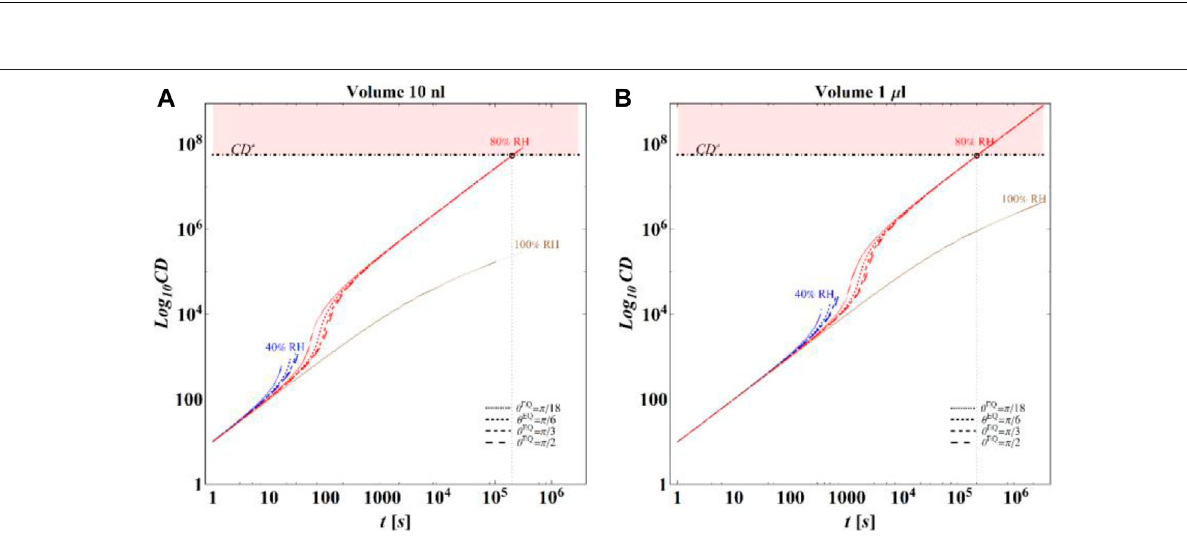
FIGURE9| Resultsofmodelsimulationsoftheevaporationprocessofasessiledropofaqueoussolutionwithastartingvolumeof1 μ L,atanRH (cid:2) 40%,intermsof time evolution of (A) the salt concentration, C salt , and (B) the volume, V, for fl at surfaces with different wettability, at T (cid:2) 25 ° C.